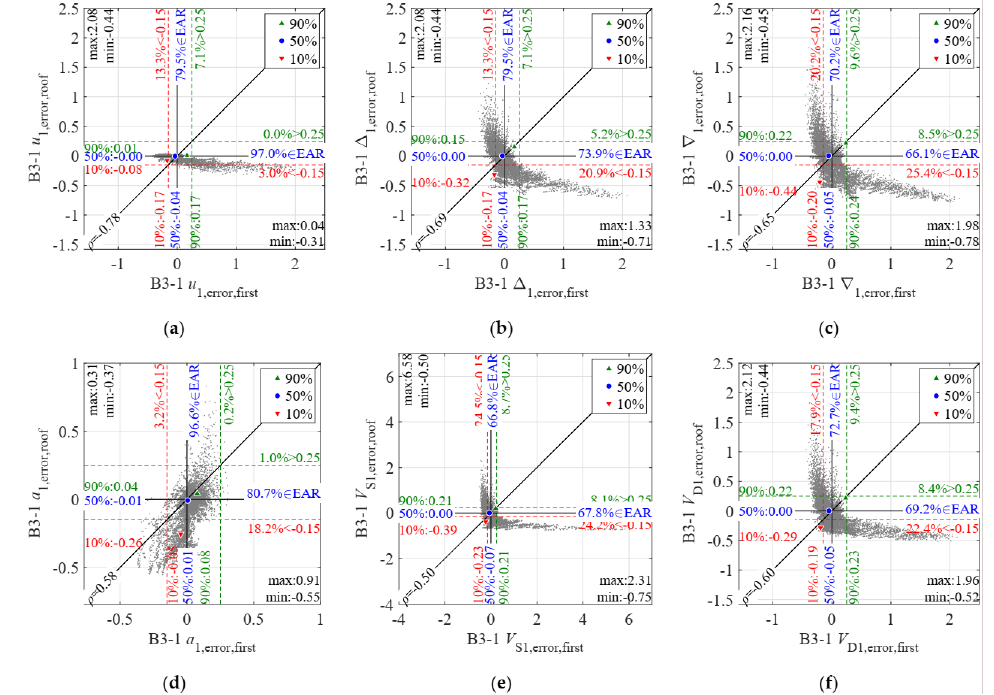
Figure 6. Scatter plots of first story error versus roof error for case B3-1: ( a ) u 1,error ; ( b ) ∆ 1,error ;